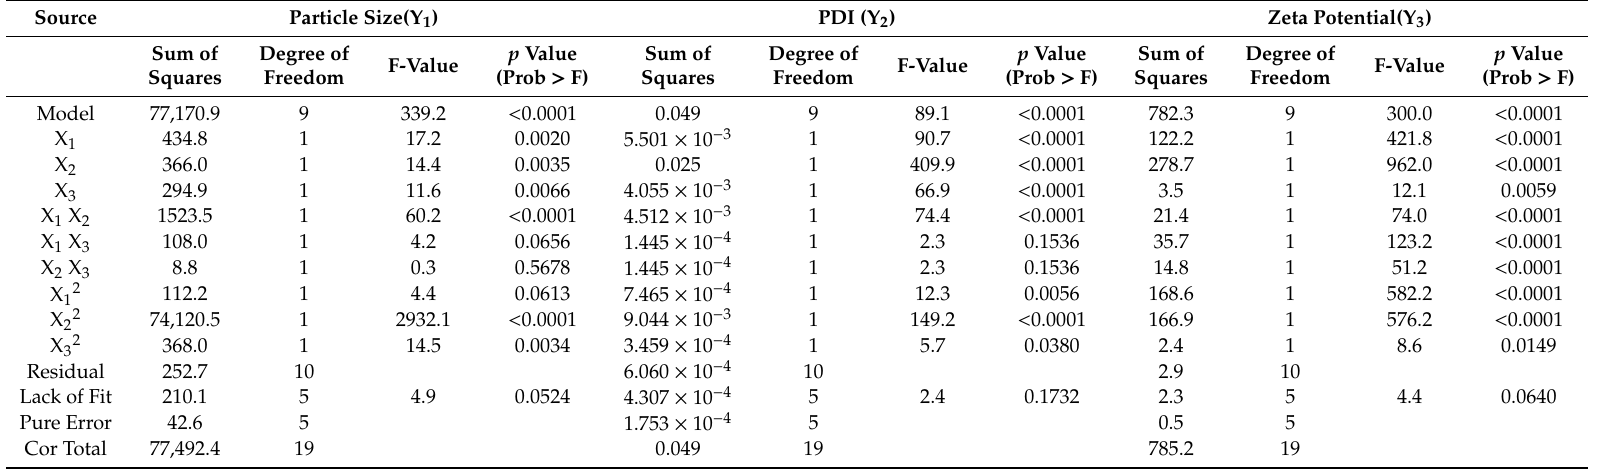
Table 3. Summary of the analysis of variance (ANOVA) for responses Y1, Y2 and Y3 in the quadratic